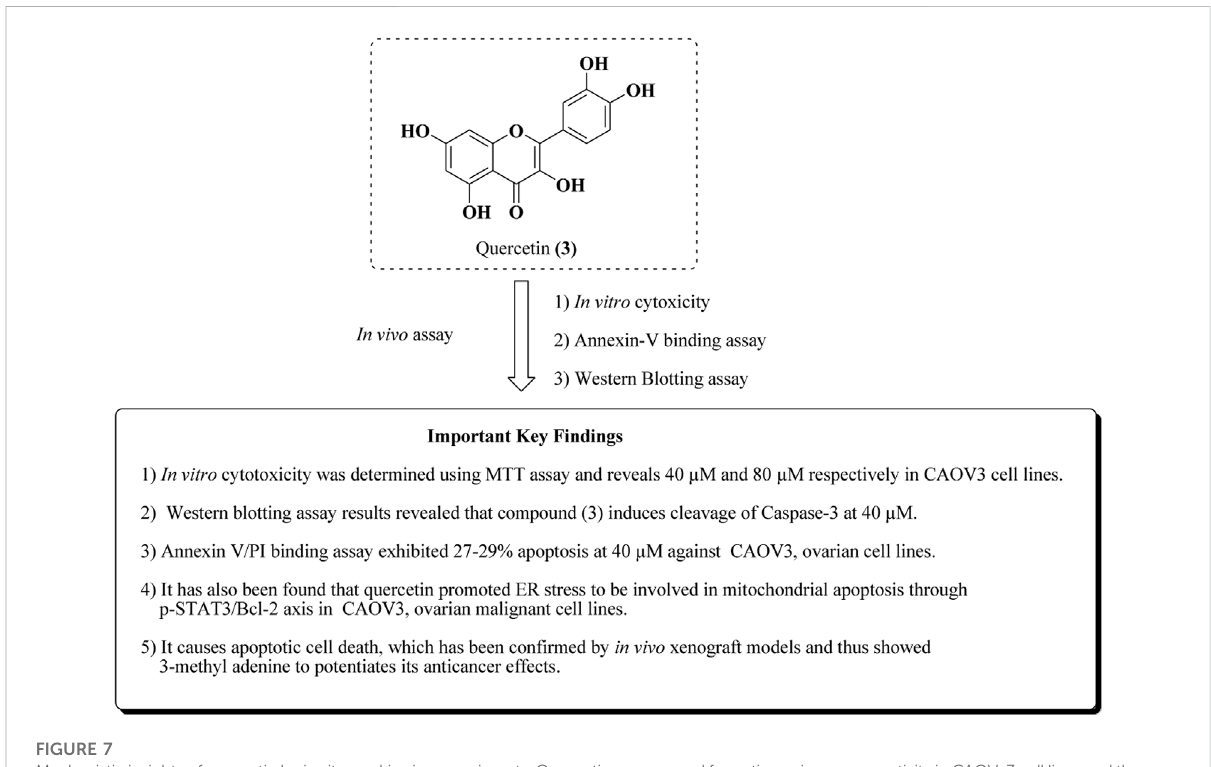
FIGURE 7 Mechanisticinsightsofquercetinby invitro and invivo experiments.Quercetinwasassayedforanti-ovariancanceractivityinCAOV-3celllinesandthe in vivo xenograft